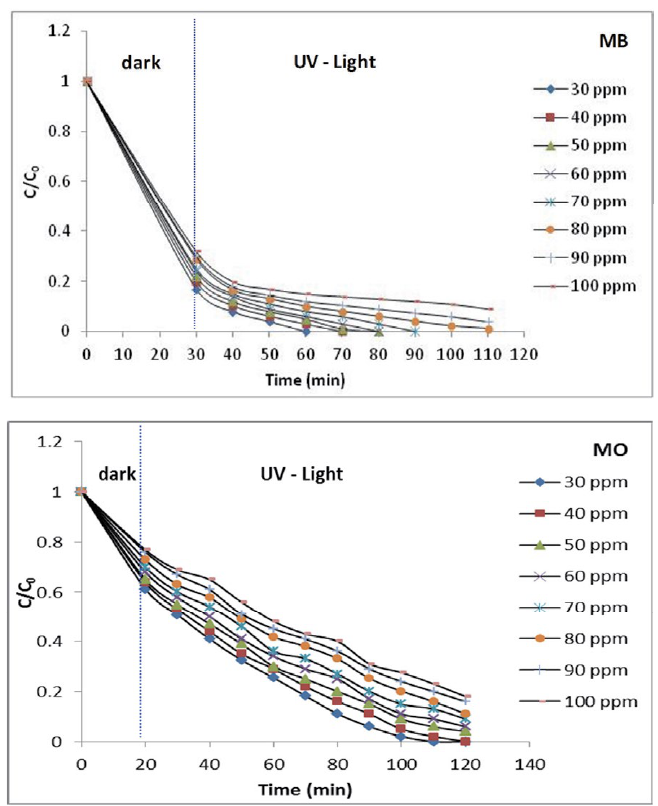
Fig. 5. Effect of initial dye concentration on the photocatalytic degradation of Fig. 5. dyes (Optimum pH values, catalyst dose = 0.01 g/l, T = 298